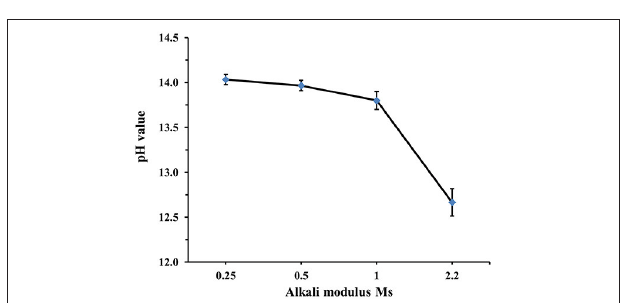
FIGURE 3 | Relationship between the alkali modulus M s and pH value of the sodium silicate solution used to give 10 wt.% activator doses (as solid content). measured after 1 h of